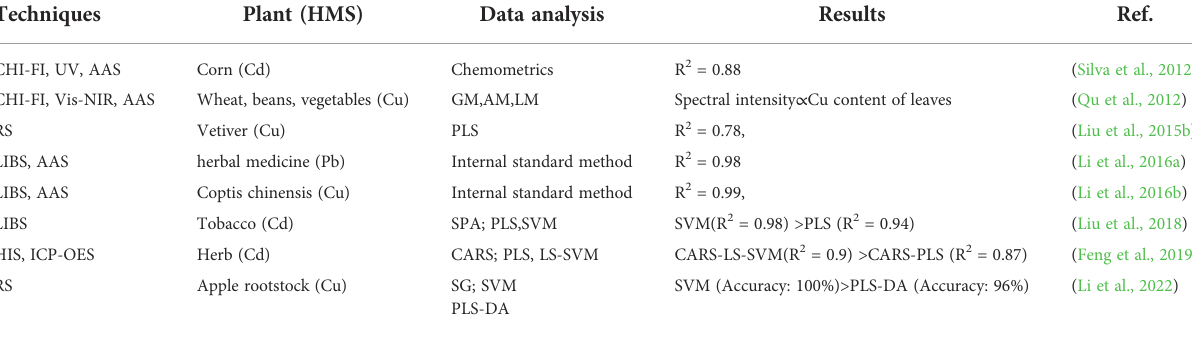
TABLE 1 Lists the application of spectral technology in the detection of roots under